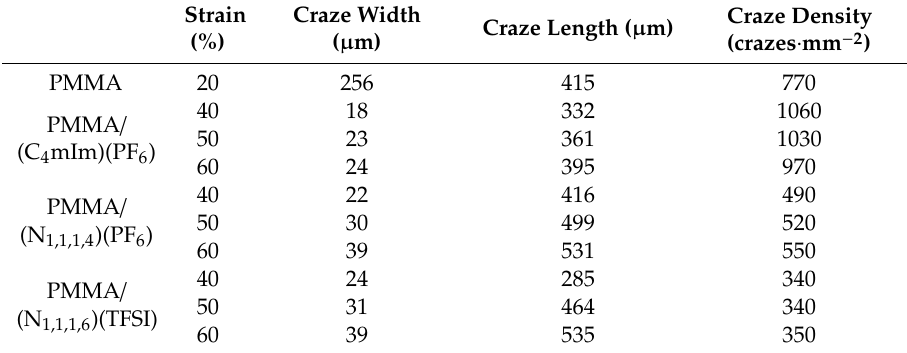
Figure 7. OM micrographs of neat PMMA and IL-modified PMMA materials at different tensile strain levels. Table 5. Craze width, length, and density obtained for neat PMMA and IL-modified for different given strains during a uniaxial tensile test performed at 20 °C.